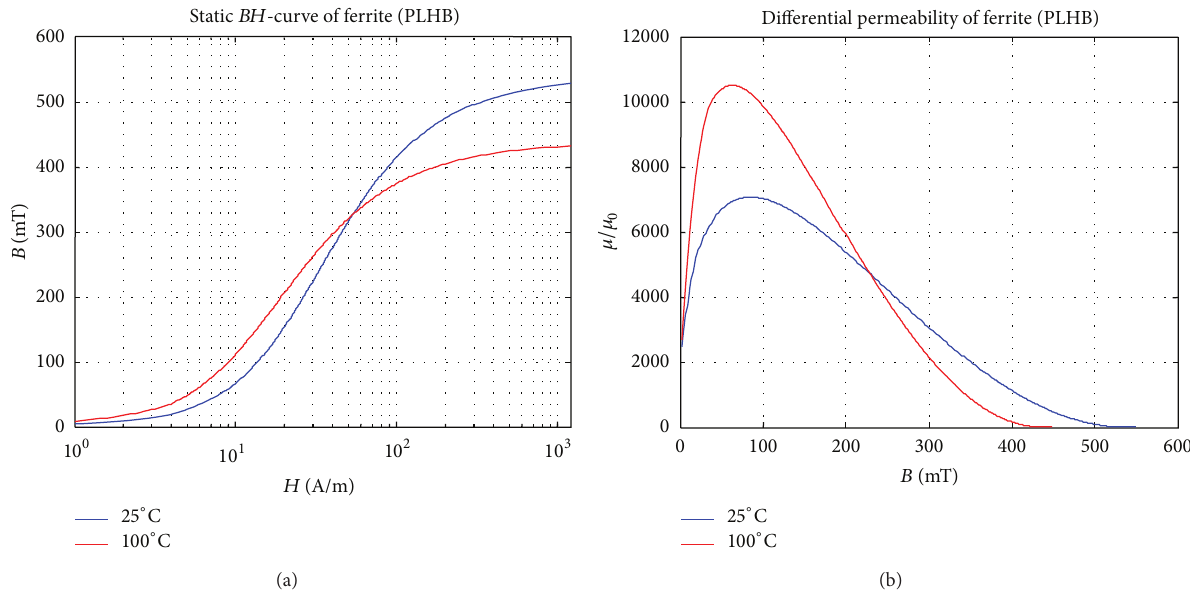
Figure 4: Measured static BH -curves (a) and differential permeabilities (b) of Samwha (PLHB) ferrite at 25 ∘ C and 100 ∘ C.